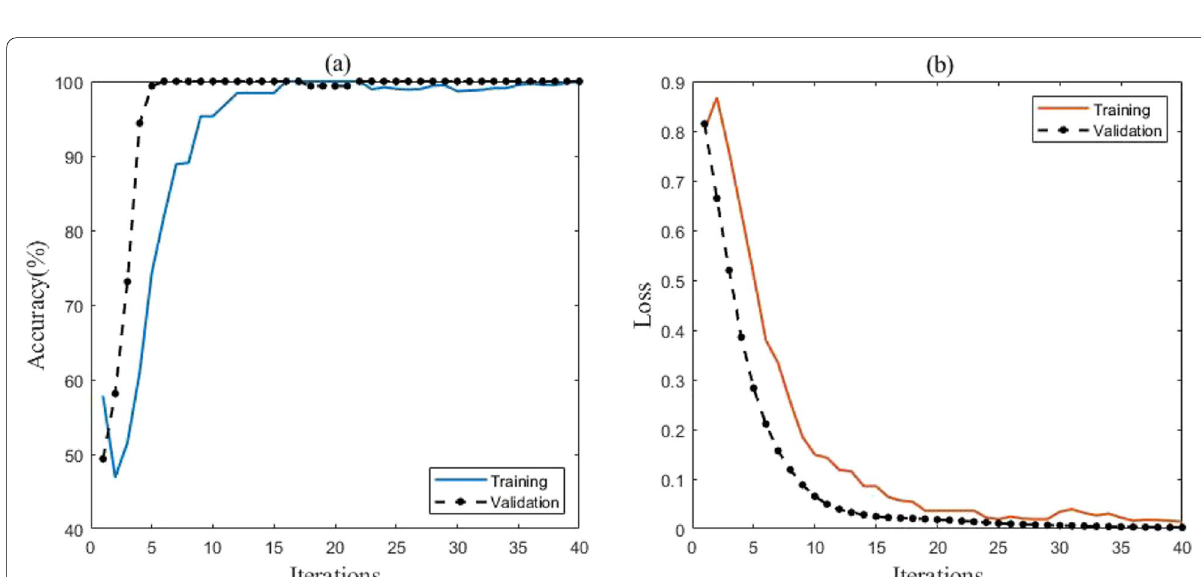
Fig. 21 Training stage: ( a ) performance and ( b ) loss of the proposed method using CWT images of undamaged and damaged conditions of the wooden